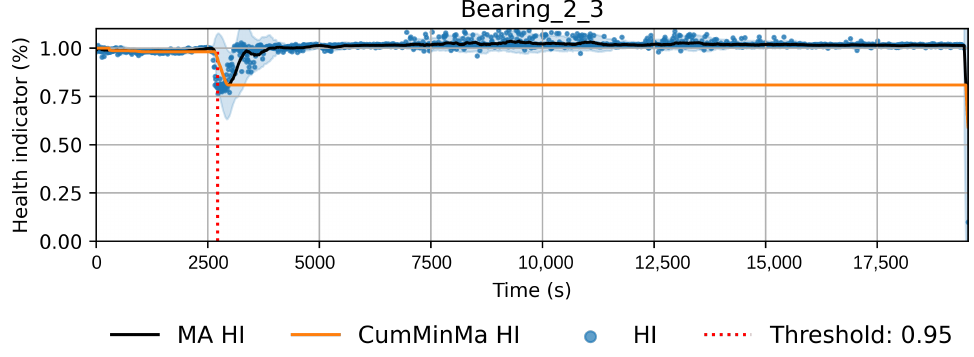
Figure 7. HI of bearing 2_2 of Pronostia dataset. The HI seems to recover gradually after time step 5000. In order to account for these types of events, the cumulative minimum is extracted as a feature.